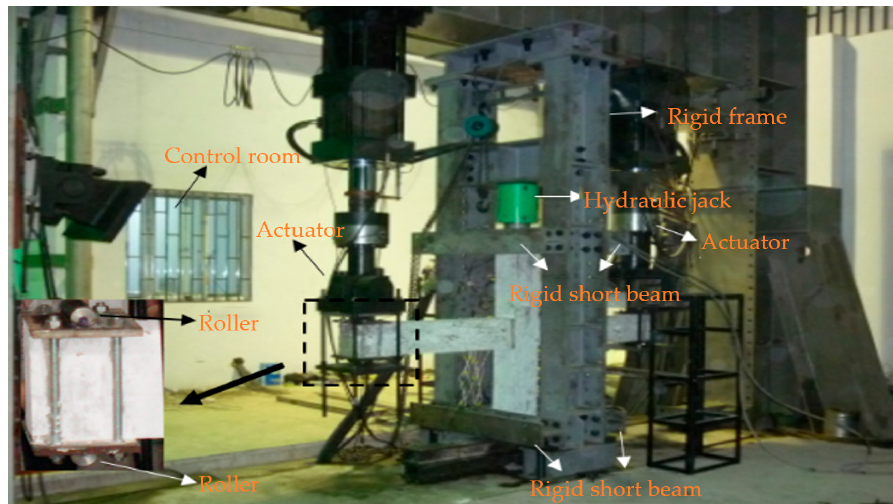
Figure 2. Schematic diagram.